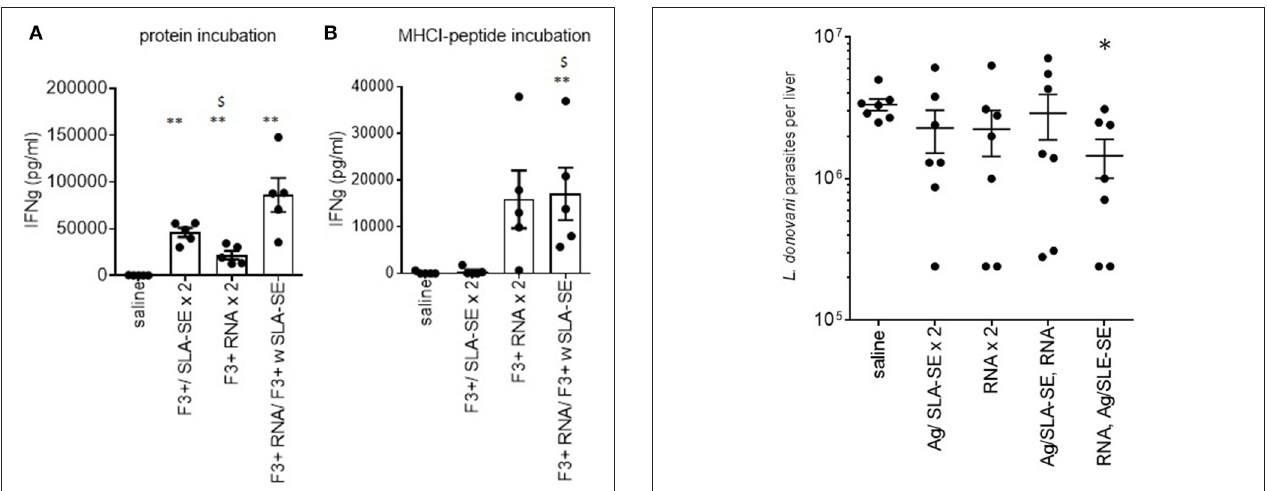
FIGURE 5 | Differential generation of CD4 and CD8T cell responses by subunit and RNA vaccines. C57BL/6 mice were immunized with the indicated homologous or heterologous regimen of vaccines incorporating the LEISH-F3 + antigen or sequence. Four weeks after the boost, spleens were removed and single cell suspensions prepared. Spleen cells were incubated with (A) F3 + protein or (B) a pool of MHCI-restricted peptides derived from F3 + . IFN γ concentration in the culture supernatants was determined by ELISA. Data are shown as mean and SEM, n = 5 per group, and are representative of results obtained in 3 independent experiments. ns = not significant, and ** = p -value < 0.01, respectively, when comparing the indicated group against the saline injected control group. $ = p -value < 0.05, when comparing the indicated group against the F3 + with SLA-SE immunized group.